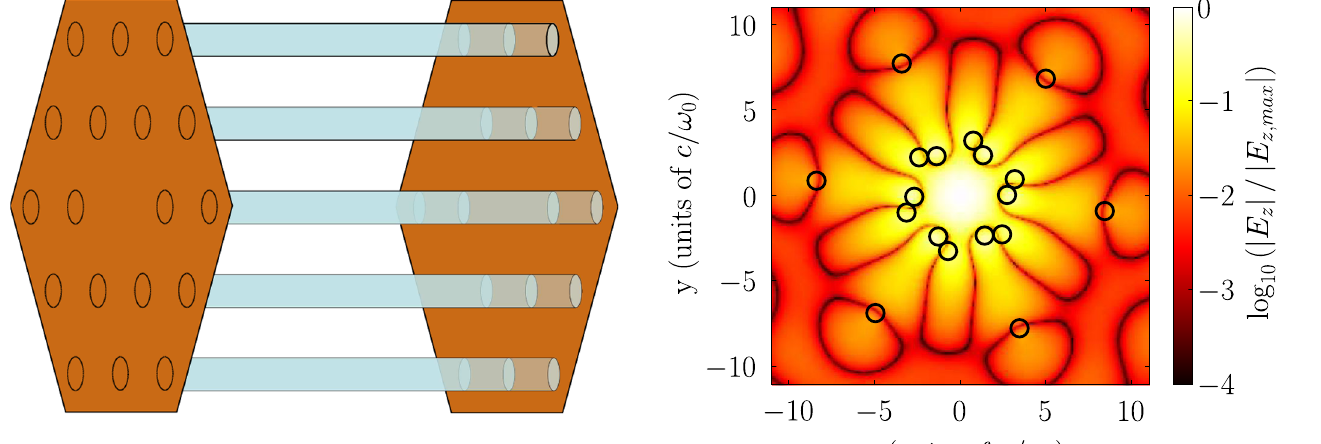
FIG. 1. (Color) A PhC cavity with dielectric rods in a triangular lattice, with the center rod removed, and metal ends. The beam travels down the center of the cavity, where the removed rod was.